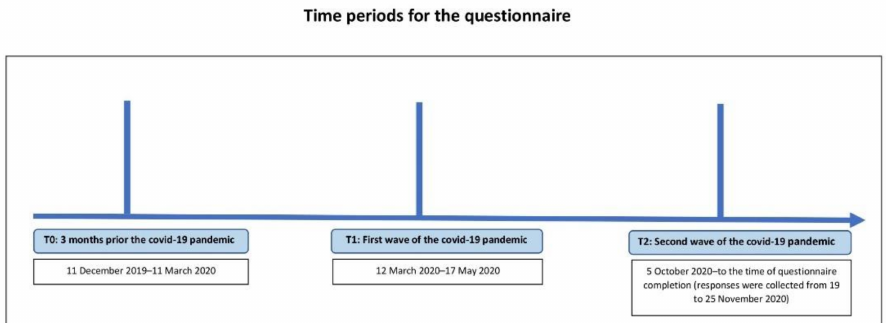
Figure 1. Time periods for the